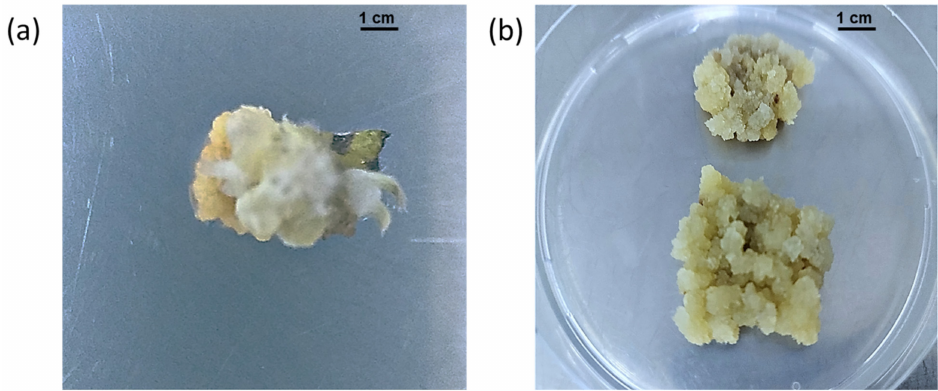
Figure 2. Callus induction using a leaf explant of C. montanus on MS media supplemented with 2.2 µ M 2,4-D and 6.9 µ M Kin ( a ) Callus induction after four weeks ( b ) Four-week-old callus culture